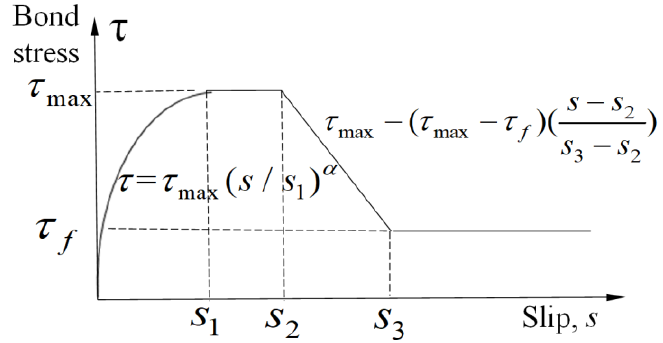
Figure 8. Analytical bond stress–slip relationship.